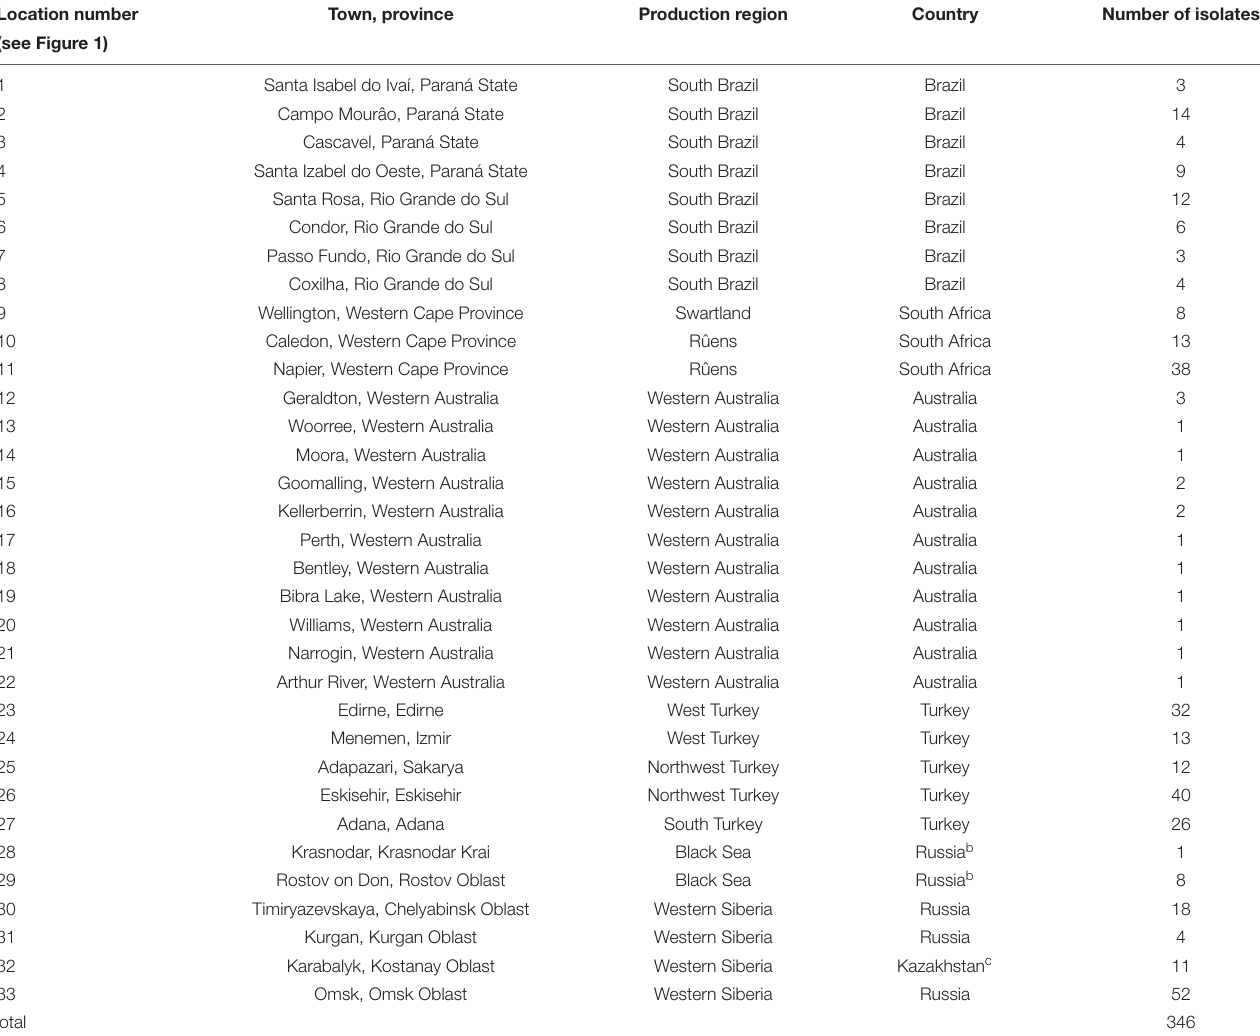
TABLE 1 | Origins of 346 Blumeria graminis f. sp. tritici isolates evaluated for virulence, including closest town and province, region, country of the collected field samples, and number of isolates recovered. a Location